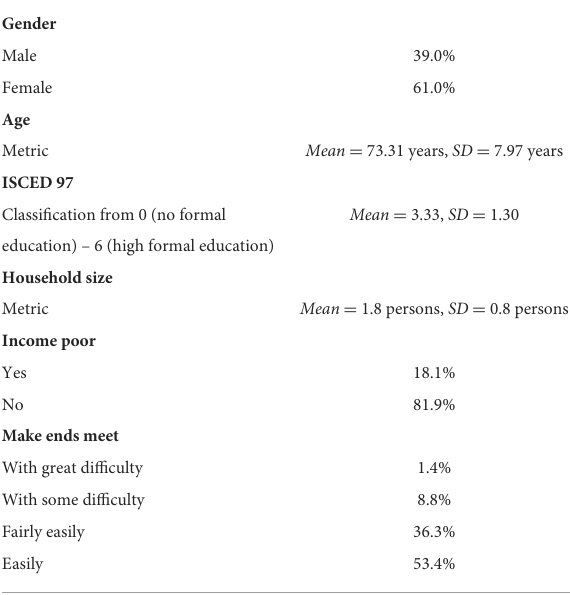
Distribution in